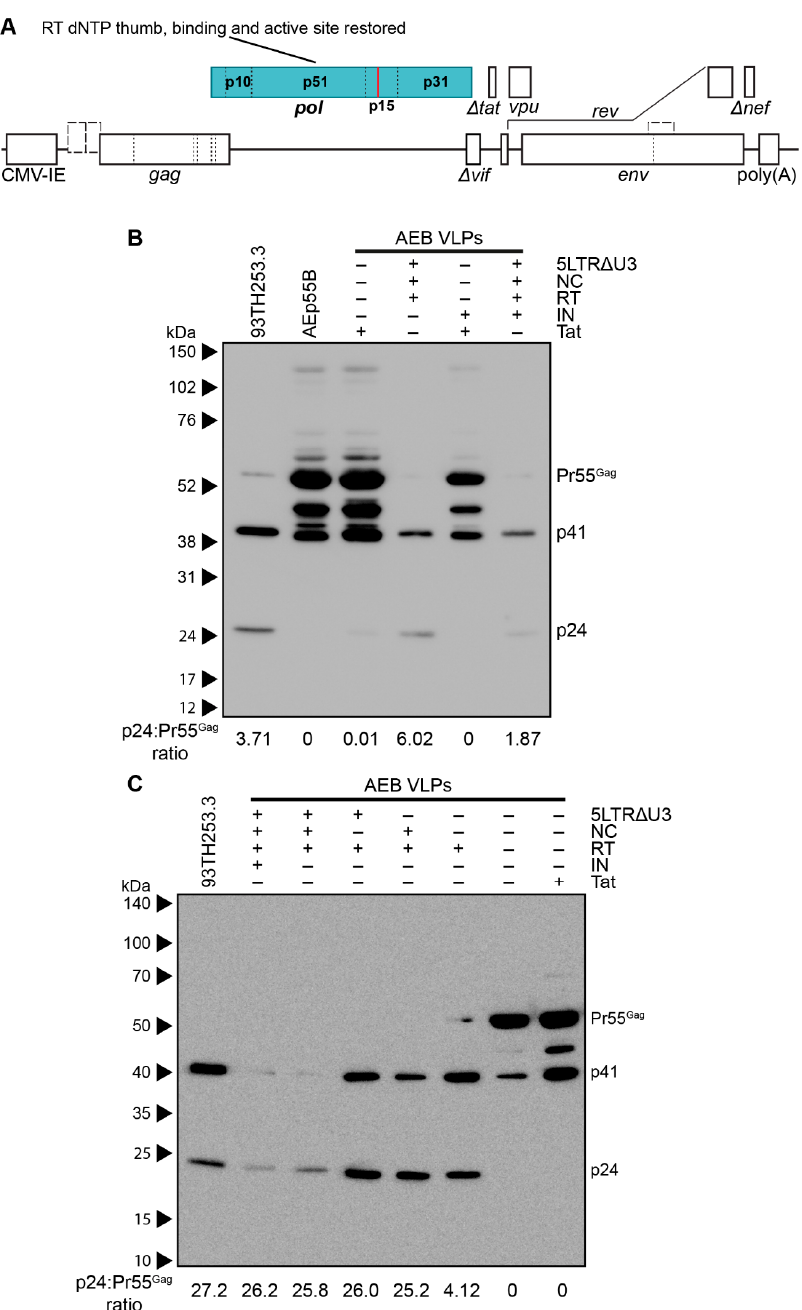
Figure 4. Characterization of VLPs with restored RT domain. ( A ) Schematic representation of the pCMV-5LTR ∆ 3-AEB.NC.RT.IN. ∆ tat VLP expression cassette. The VLP expression cassette of pCMV-5LTR ∆ 3-AEB.NC.RT. ∆ tat is also represented by this schematic, except that it lacks the IN domain (p31). Abbreviations, deletions and modifications are as described in Figure 1A. Newly introduced or modified ORFs relative to Figure 3B are indicated by filled in blocks. ( B , C ) Representative Western blots using anti-p24 (#24-4) on VLPs and the 93TH253.3 parental virus. AEB VLPs are shown along with VLPs expressing one or more of a truncated 5 (cid:48) LTR (5LTR ∆ U3), functional nucleocapsid (NC), functional reverse transcriptase (RT), functional integrase (IN), and functional Tat protein (Tat), as indicated. All of the samples were resolved by 8–16% SDS-PAGE. The positions of Gag polyprotein cleavage products are indicated on the right and the protein sizes are indicated on the left by ( B ) Amersham ECL Full-Range Rainbow Molecular Weight Markers or ( C ) Spectra Multicolor Broad Range Protein